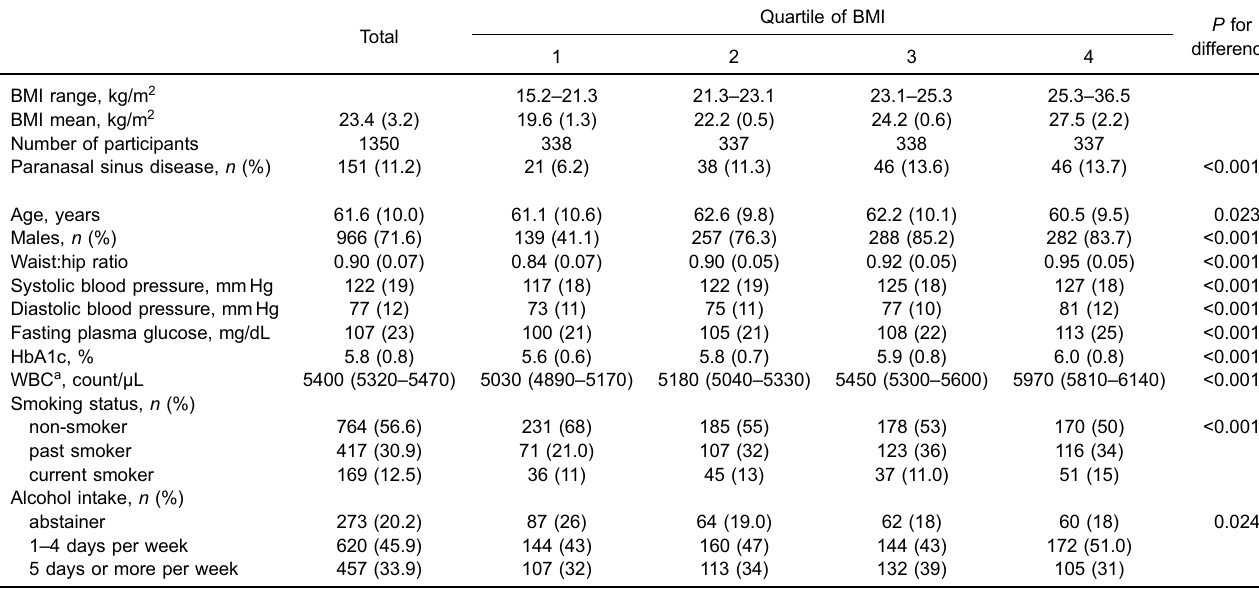
Quartile of BMI P for